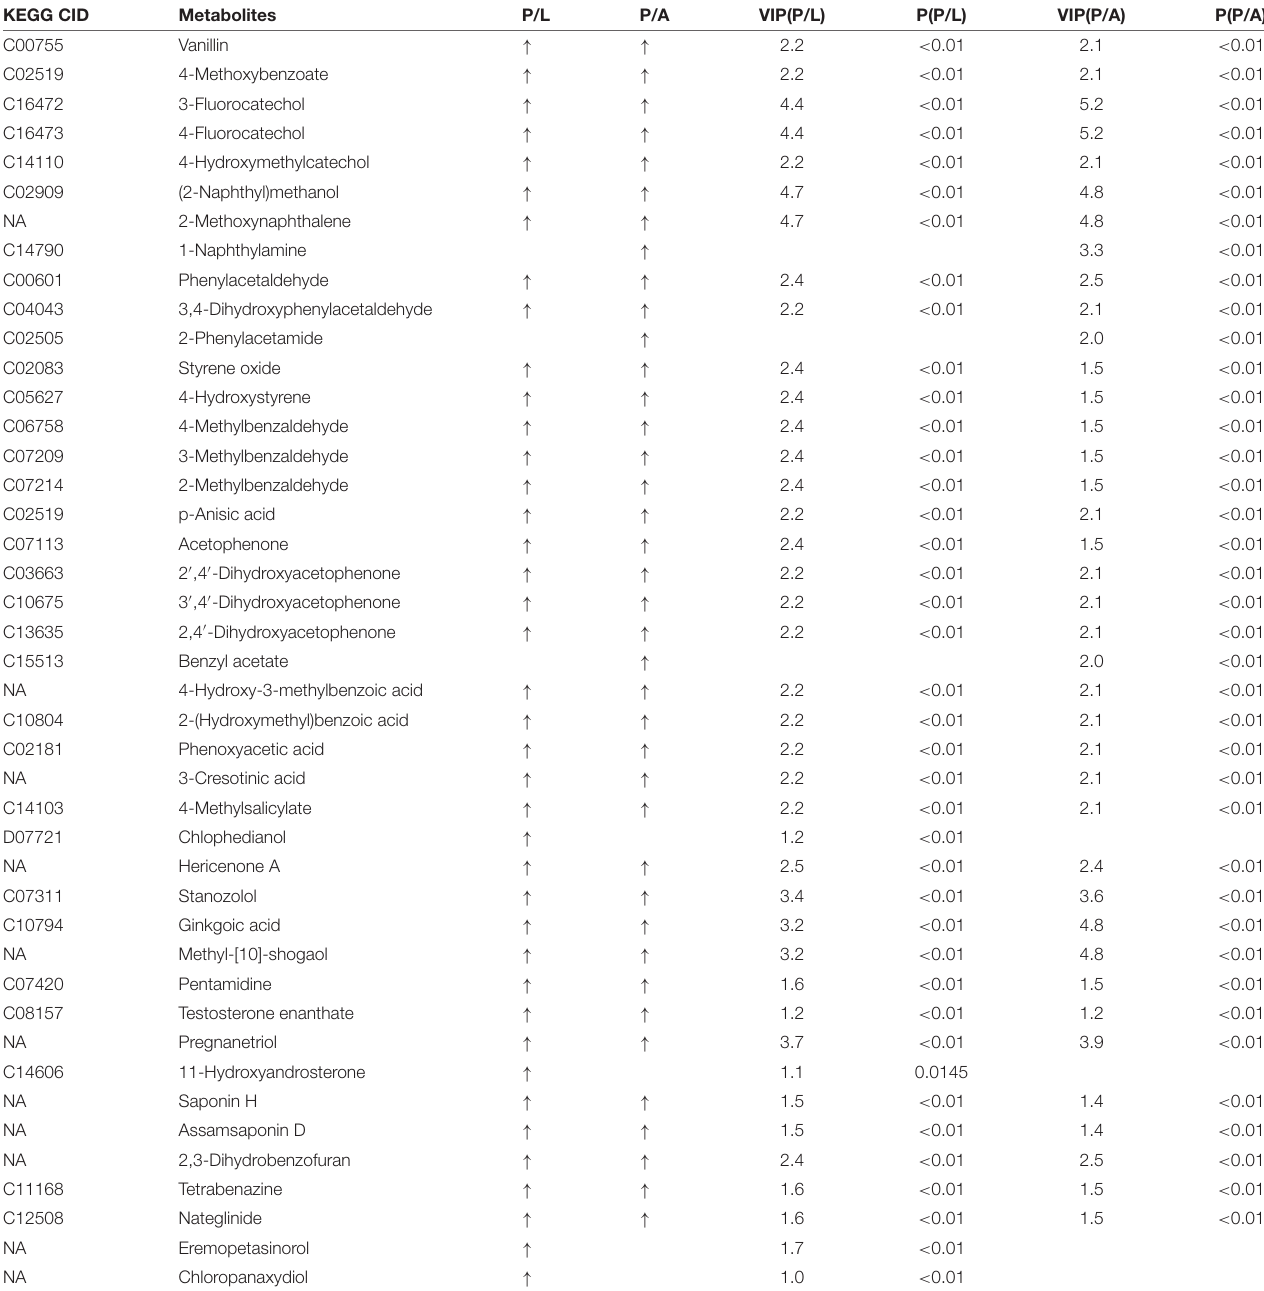
TABLE 1 | Differential xenobiotics with higher levels in pupae v.s. larvae/adults in positive ion mode. KEGG CID Metabolites P/L P/A VIP(P/L) P(P/L)